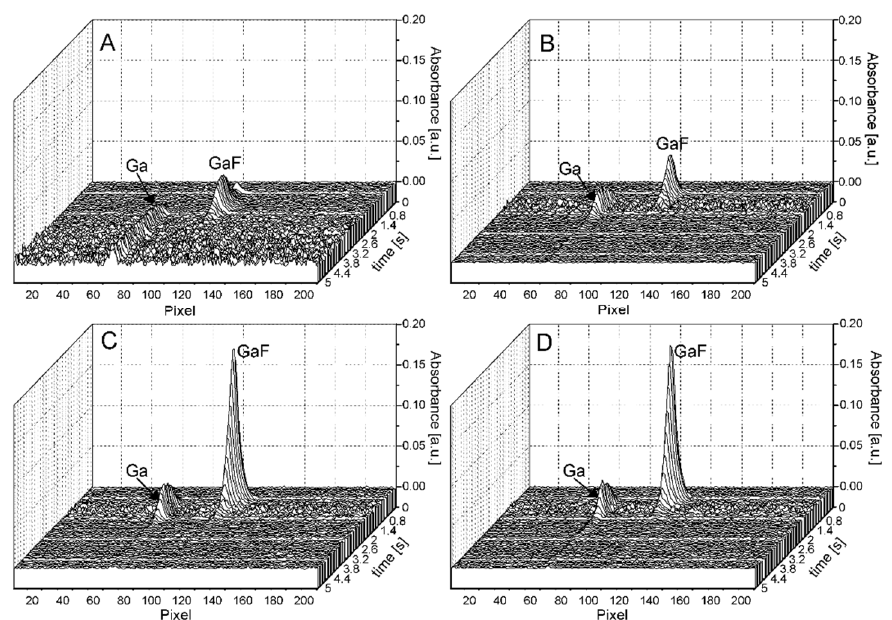
Figure 6. Time- and wavelength-resolved absorbance spectrum during the analysis of F (NaF SRM) in a form of GaF (pixels correspond to the wavelength range between 211.1215 nm and 211.3732 nm) without modifiers ( A ) 1 ng F in water, and with modifiers: ( B ) 0.2 ng F in water; ( C ) 1 ng F in water;